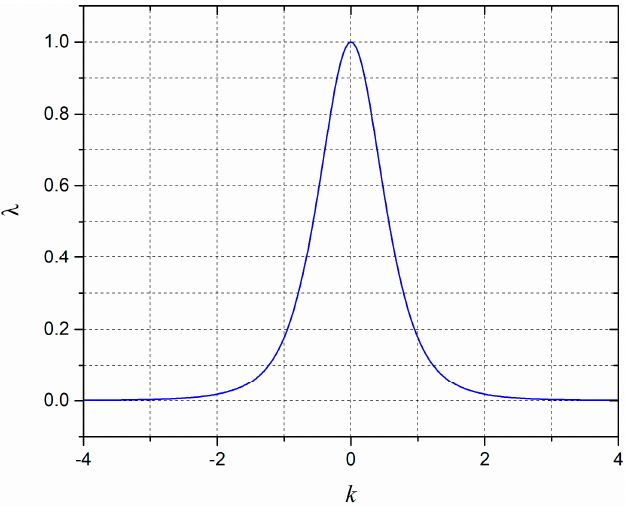
Figure 3. The relation curve between λ and k .